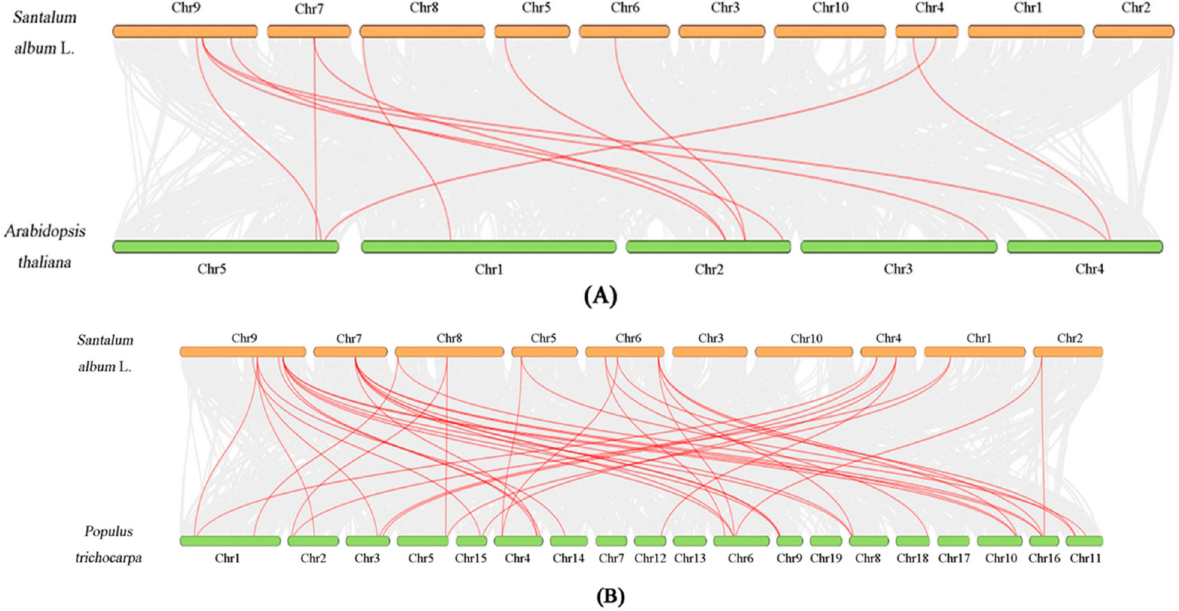
Figure 6. Collinearity contrast between S. album and two representative plants, poplar and Arabidopsis . ( A ) Collinearity analysis of S. album and Arabidopsis thaliana . ( B ) Collinearity analysis diagram of S. album and Populus trichocarpa . The gray lines in the background represent collinear blocks within the S. album and Arabidopsis and poplar genomes, while the red lines highlight collinear ARF gene